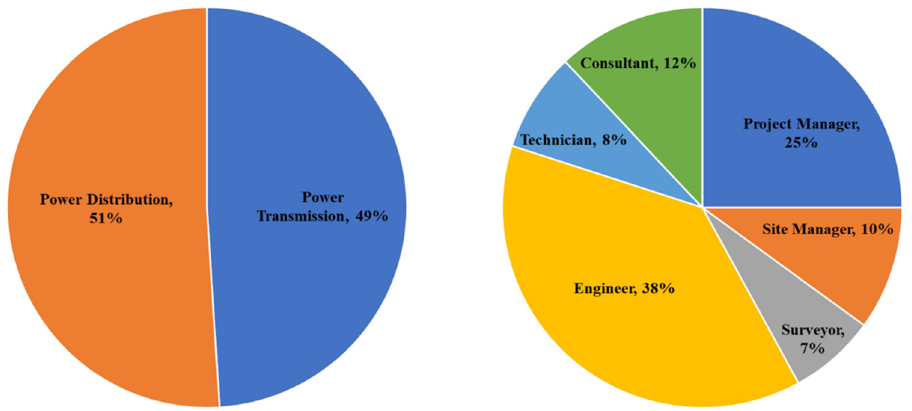
Figure 1. Sector and Job Position of